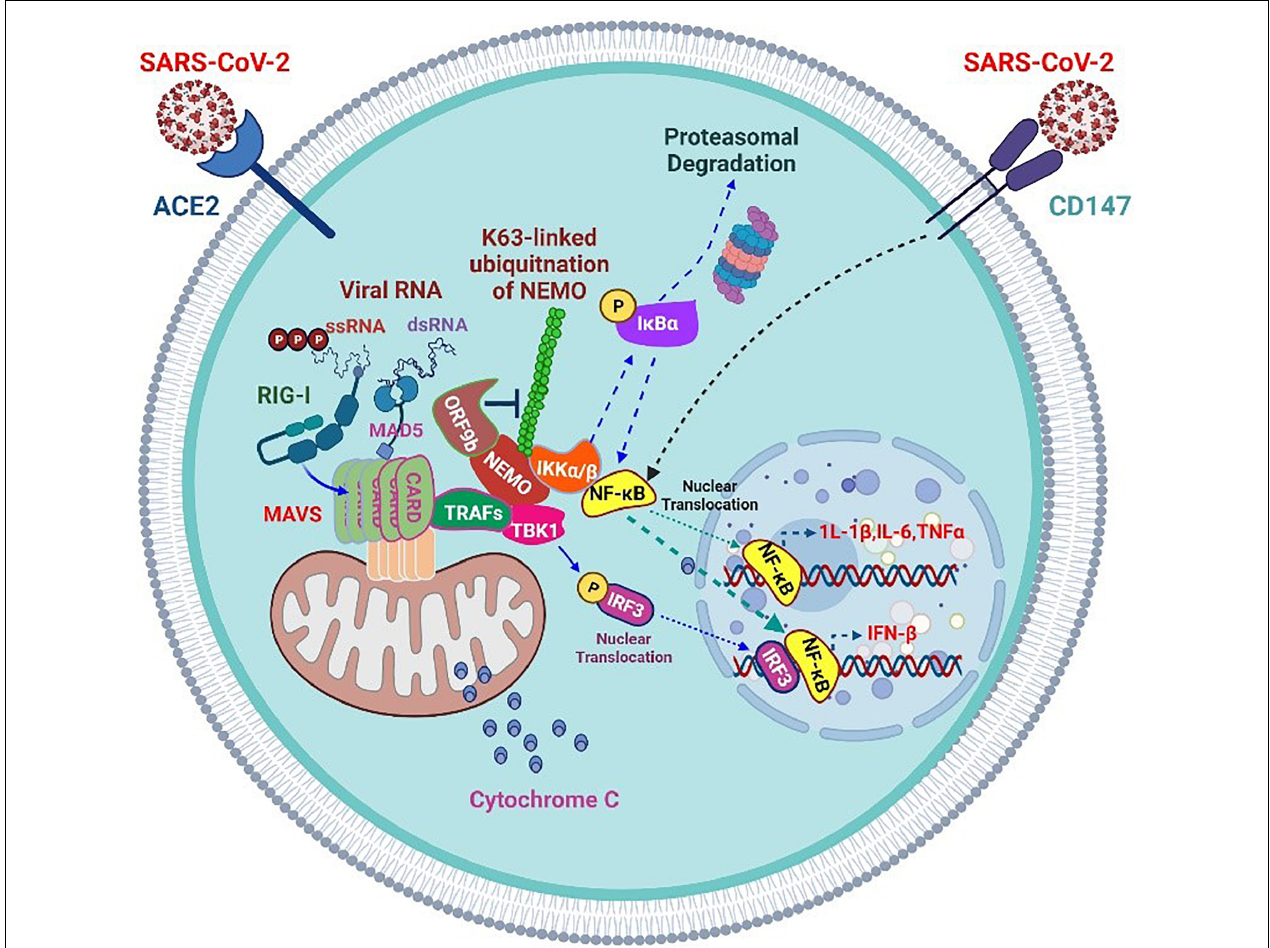
FIGURE 4 | Severe acute respiratory syndrome coronavirus 2 accessory proteins inhibit RIG-I/MAD5-MAVS antiviral signaling but enhance CD147 inflammatory